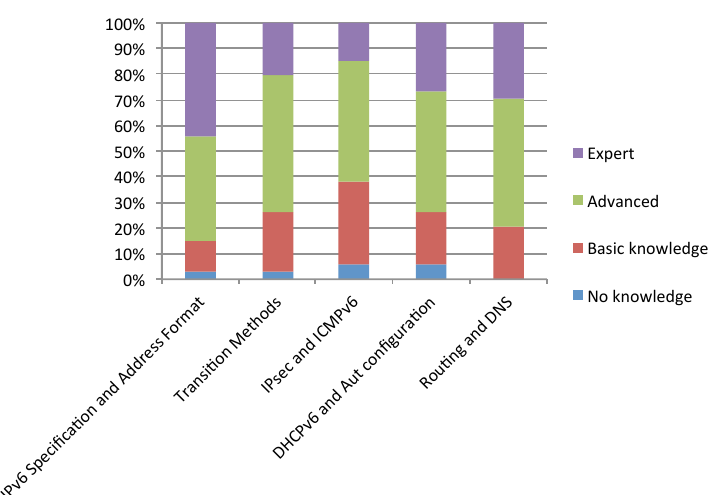
Figure A5. IPv6 knowledge.